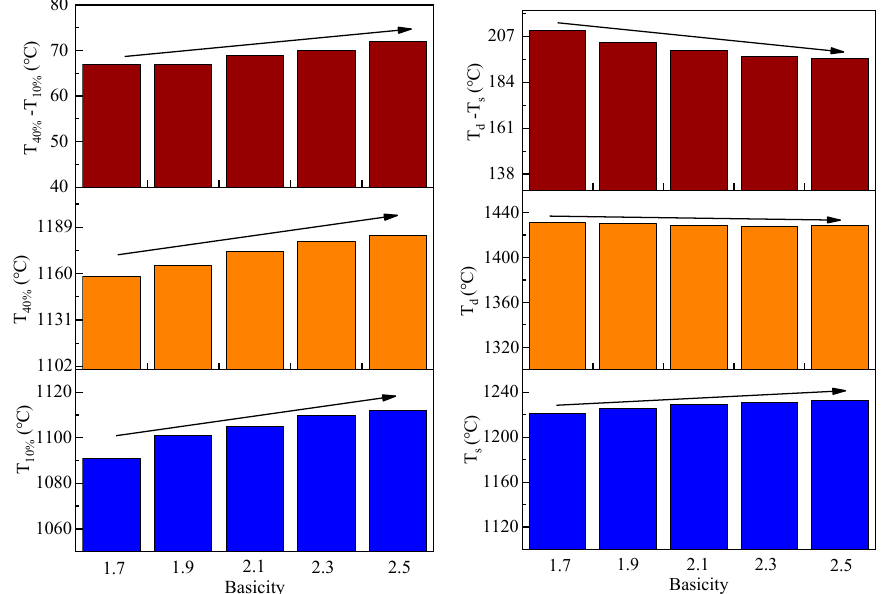
Figure 10. Sinter softening-melting properties with different basicity.